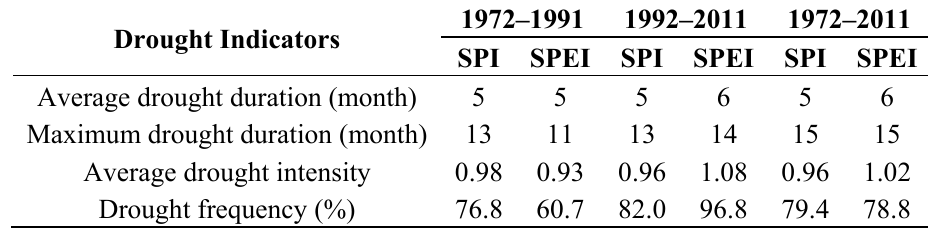
Table 2. Regional duration, intensity and frequency of drought events identified from SPI/SPEI values at a 3-month scale for different periods in Ningxia.